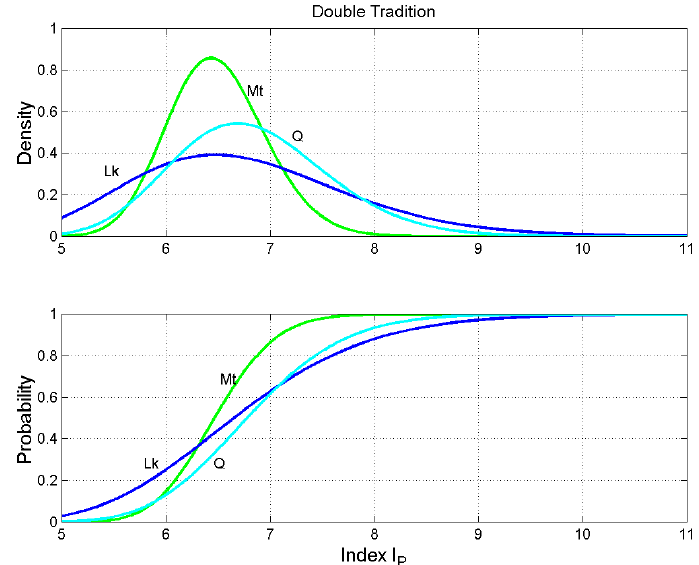
Figure 12. Double Tradition. Probability density functions (upper panel) and probability distribution functions (lower panel) of the number of words per interpunctions (word interval) 𝐼 𝑃 . Matthew : green line; Luke : blue line; Q : cyan line.